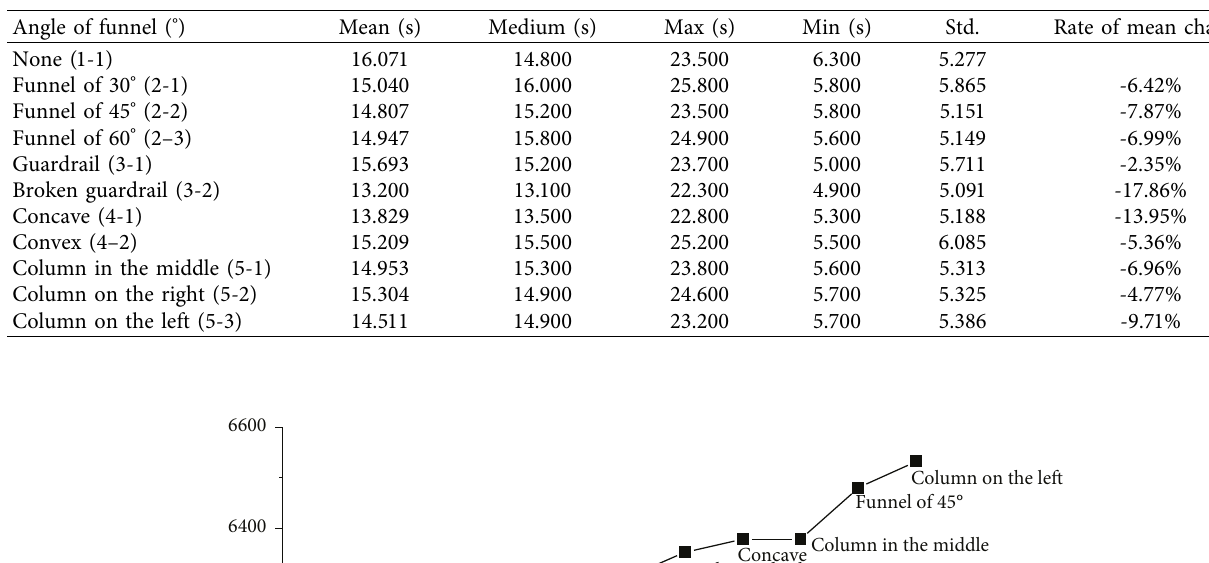
Table 2: Experiments scenario configurations.